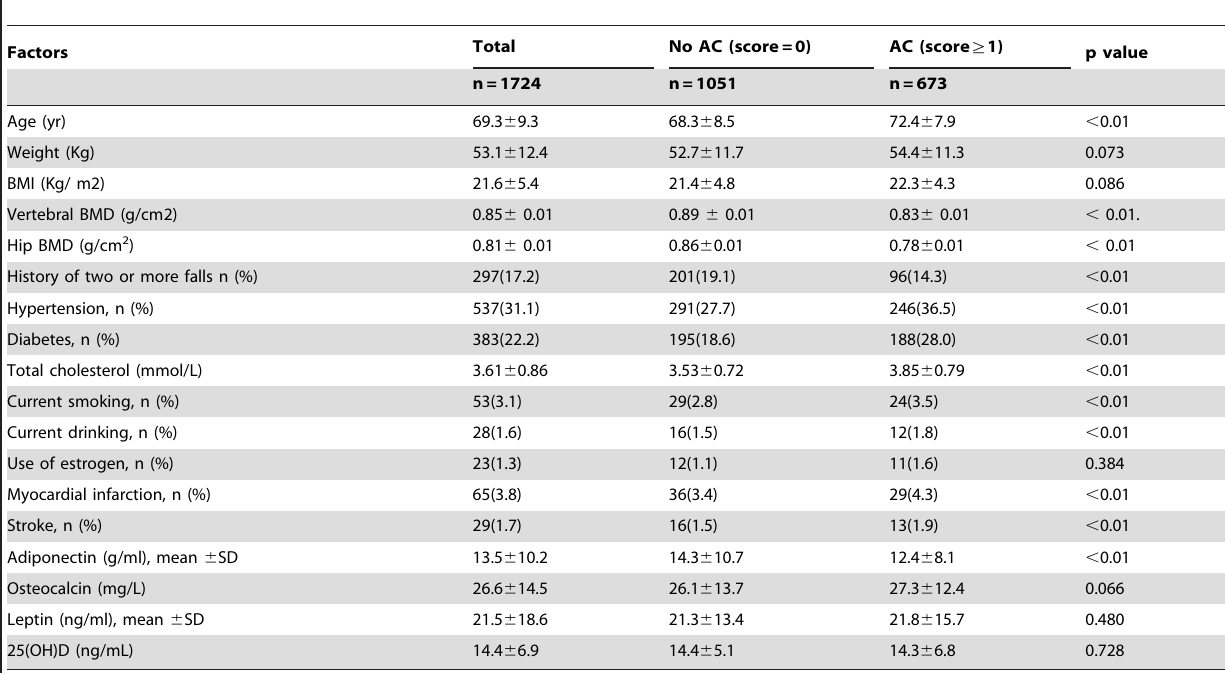
Table 1. Baseline characteristics of the subjects who developed aortic calcification and who did not in the study of 1724 women.